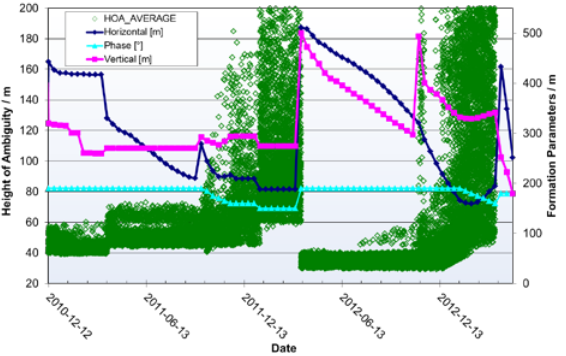
Figure 2: Height of ambiguity and formation parameters (horizontal and vertical separations) for global DEM